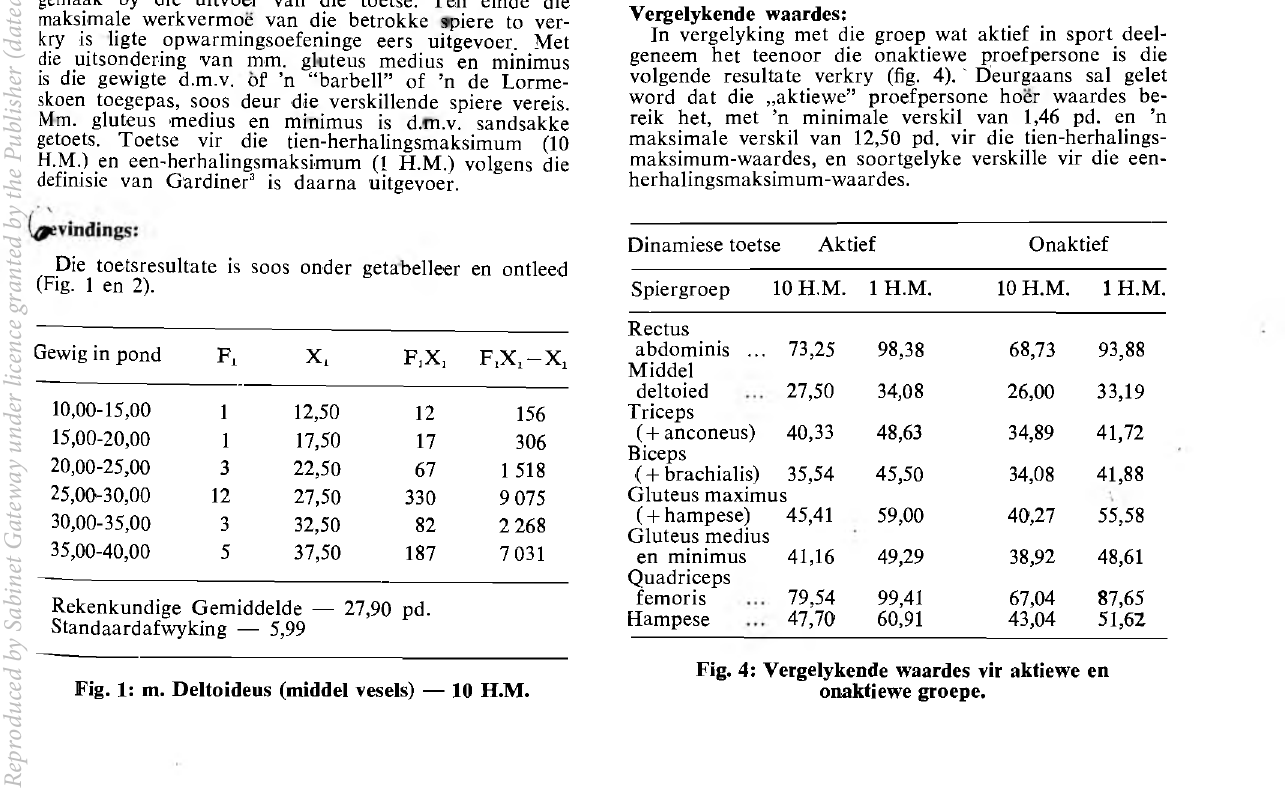
Fig. 1: m. Deltoideus (middel vesels) — 10 H.M.